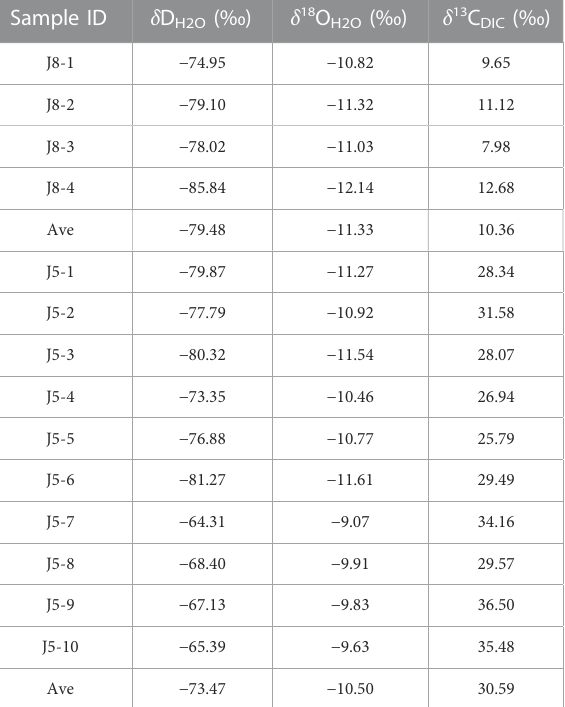
TABLE 2 Hydrogen and oxygen isotopic and DIC carbon isotopic compositions of coalbed-produced water in the Linfen mining